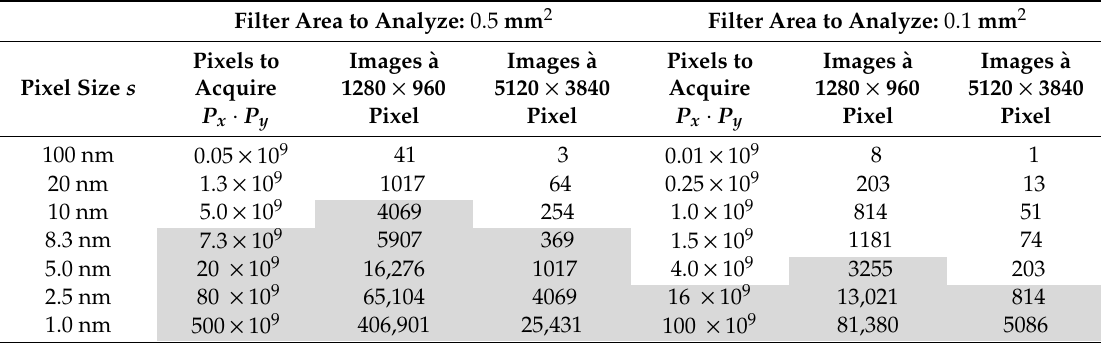
Table 4. Number of pixels and images to acquire for analyzing 0.5 mm 2 or 0.5 mm 2 / 5 = 0.1 mm 2 filter area. Image numbers of currently hardly or not yet manageable workload are marked in